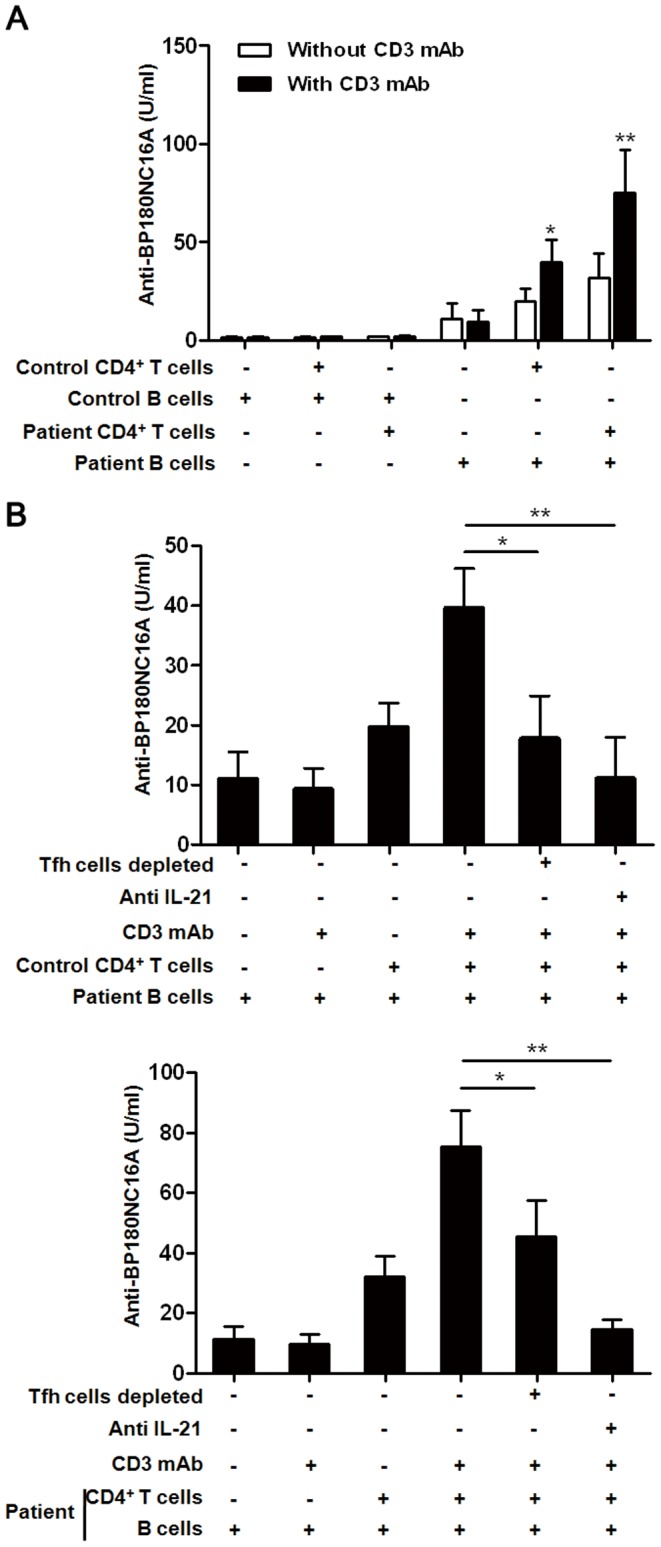
Tfh cells help the secretion of autoantibody in CD4+ T cells/B cells co-cuture in vitro.(A) Secretion of autoantibody in CD4+ T cells/B cells co-cuture system. Peripheral CD19+ B cells(1.5×105 cells/well) and CD4+ T cells(1.5×105 cells/well) from 6 healthy controls and 6 BP patients were cultured alone or together for 7 days and then the secretion of autoantibody were detected. (B) Secretion of autoantibody in CD4+ T cells/B cells co-cuture system after depletion of Tfh or inhibition of IL-21. CD4+CXCR5+ T cells were cleaved from the co-culture system by sorting on a FACSAria flow cytometer to evaluate the function of Tfh cells in BP autoantibody secretion. The effect of inhibiting IL-21 were examined by adding neutralizing anti-IL-21 polyclonal Ab. CD19+ B cells alone or culture with anti-CD3 Ab were the negative control. Results shown are from a representative experiment of three independent experiments. *P<0.05, **P<0.01.